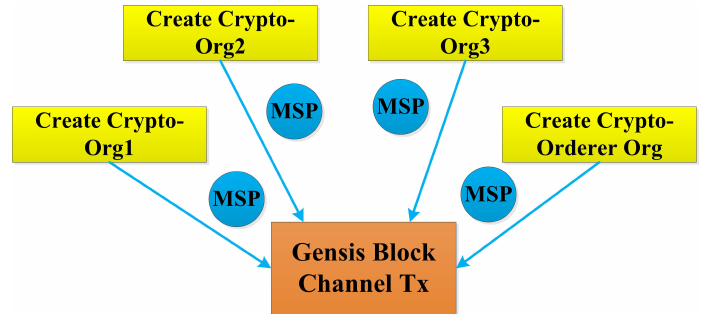
Figure 3. Genesis block creation by crypto